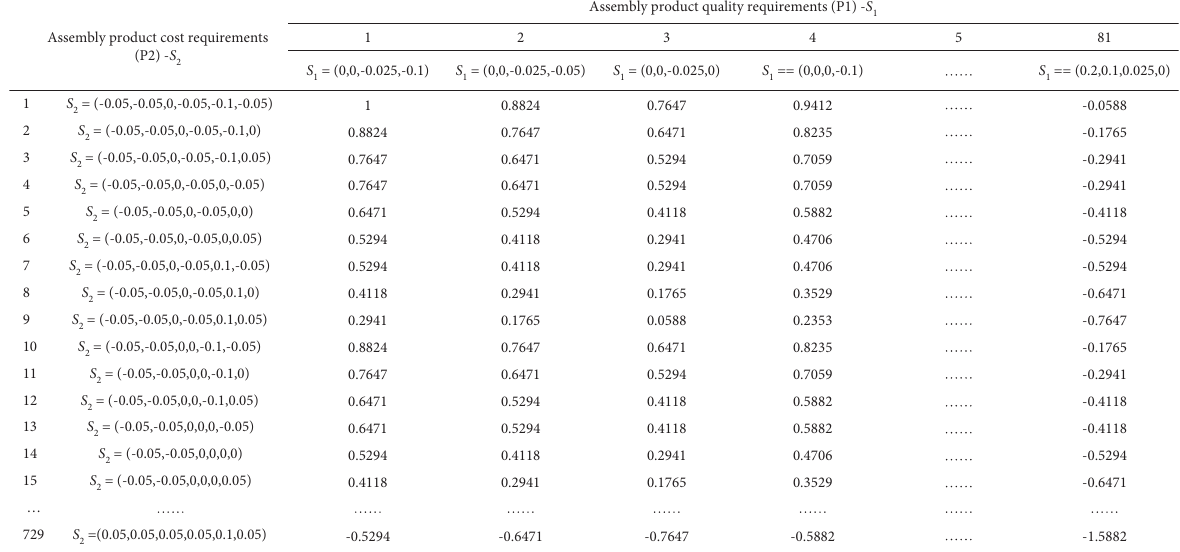
Figure 7: The game utility matrix of alliance